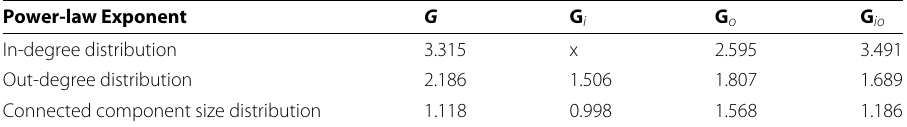
Table 3 Exponents for the various power-law distributions characterizing the structure of G , G i , G o , and G io . Because of the trivial nature of the G i in-degree graph, its in-degree exponent does not have the usual interpretive validity (as it does not remotely resemble a power law distribution); hence, we denote it with an x Power-law Exponent G G i G o G io In-degree